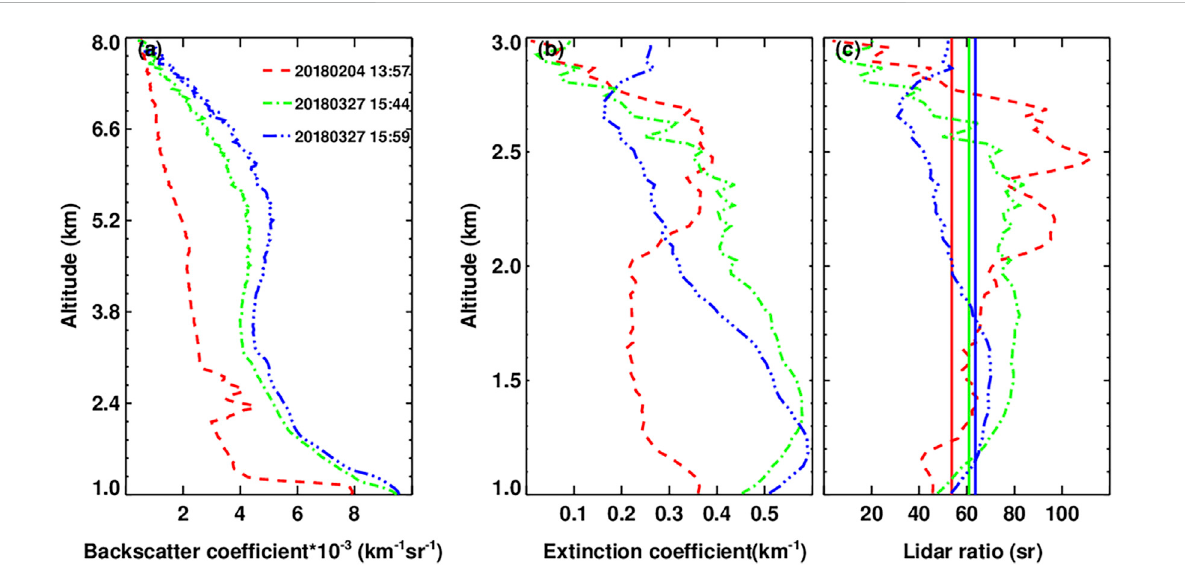
FIGURE 12 Backscatter coef fi cients (A) , extinction coef fi cients (B) , and lidar ratios (C) derived from Raman-Mie lidar on Feb. 04 13:57 (red dotted line),Mar. 27 15:44 (green dotted line), and Mar. 27 15:59 (blue dotted line), 2018. Red, green and blue solid lines denote the column-averaged lidar ratio from sky-radiometer at different times corresponding to lidar.